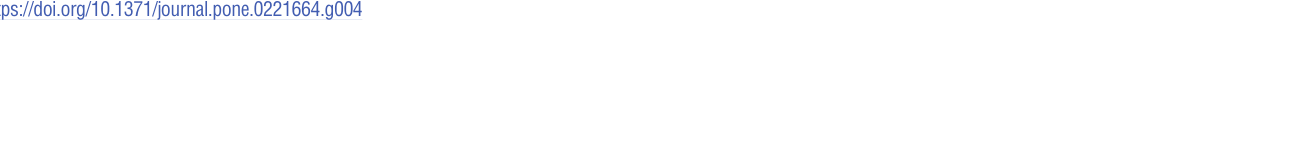
PLOS ONE | https://doi.org/10.1371/journal.pone.0221664 August 28,